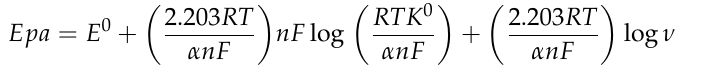
6 Table 1. Nyquist plot parameters in the presence and absence of H 2 O 2 with χ 2 values between 1.5 and 2.5%.